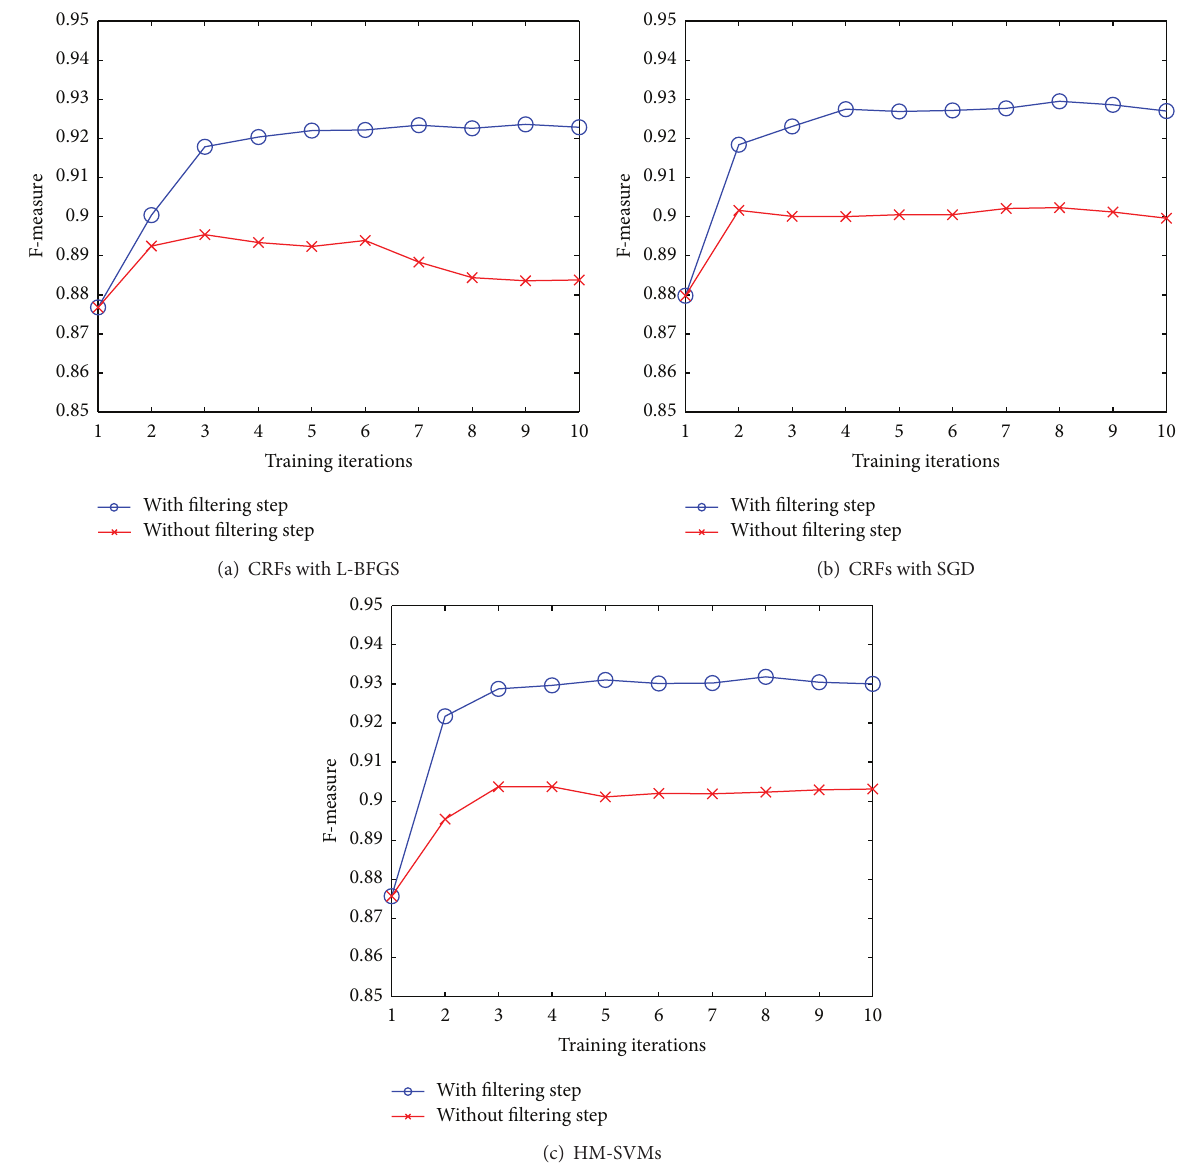
Figure 5: Comparisons of performance with or without the filtering